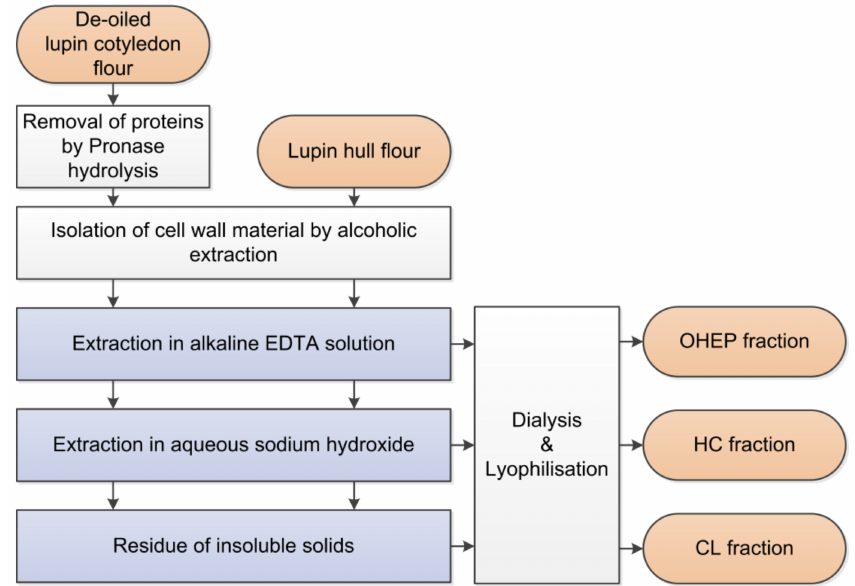
Figure 1. Sequential fractionation of cell wall material obtained from the cotyledon and the hull of L. angustifolius L. Boregine (pectin-like fraction (OHEP), hemicellulose fraction (HC), and cellulose-lignin fraction (CL))